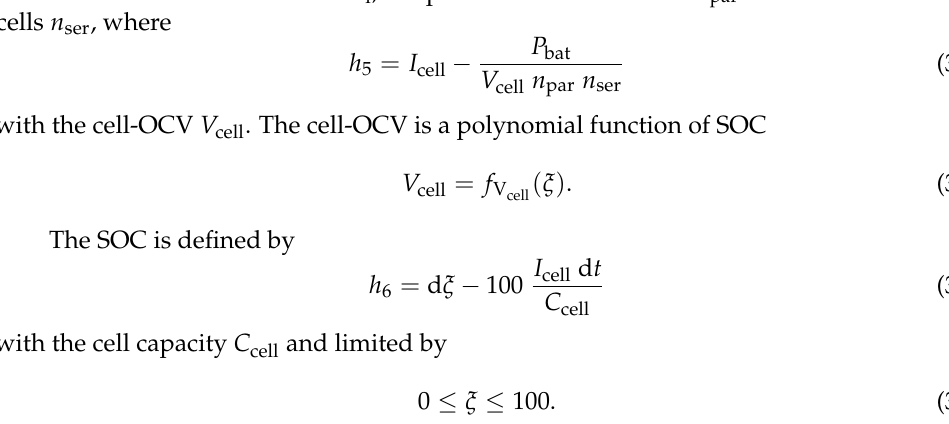
with the internal cell resistance R i , the parallel number of cells n par and serial number of cells n ser ,